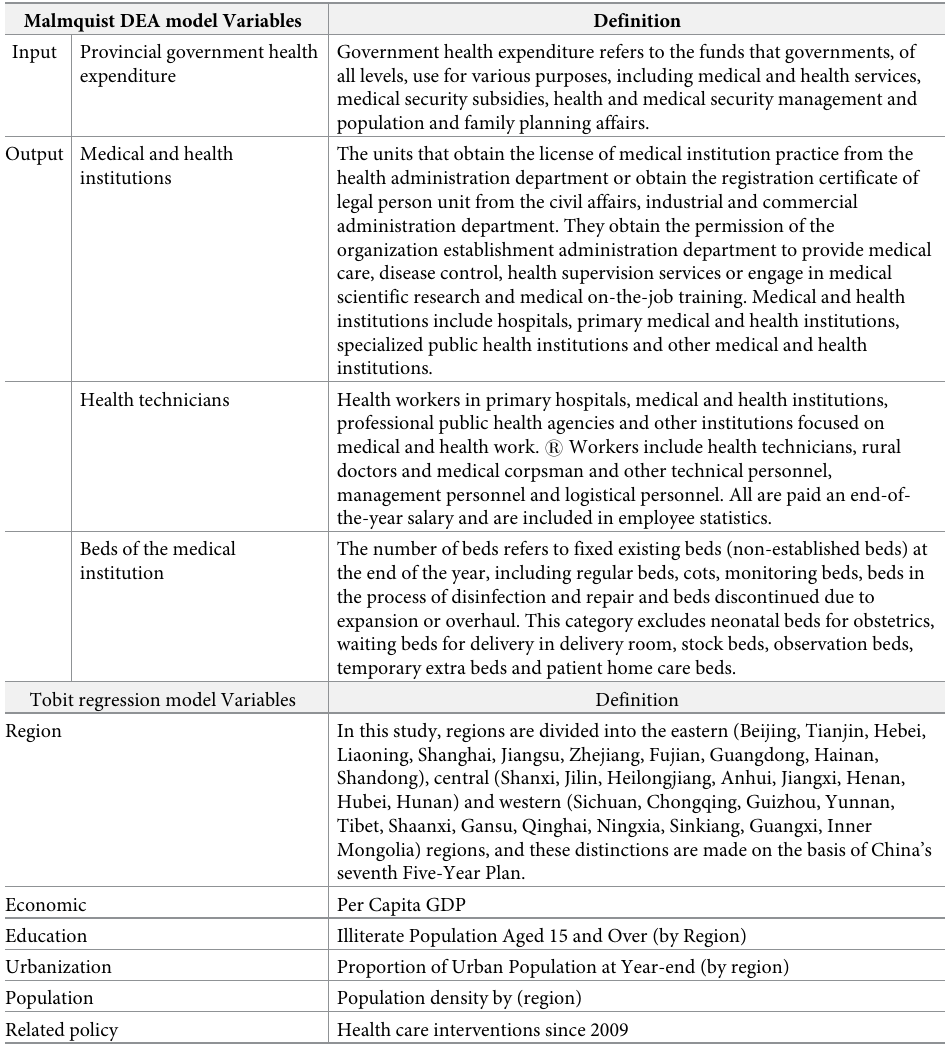
Table 1. Definition of the